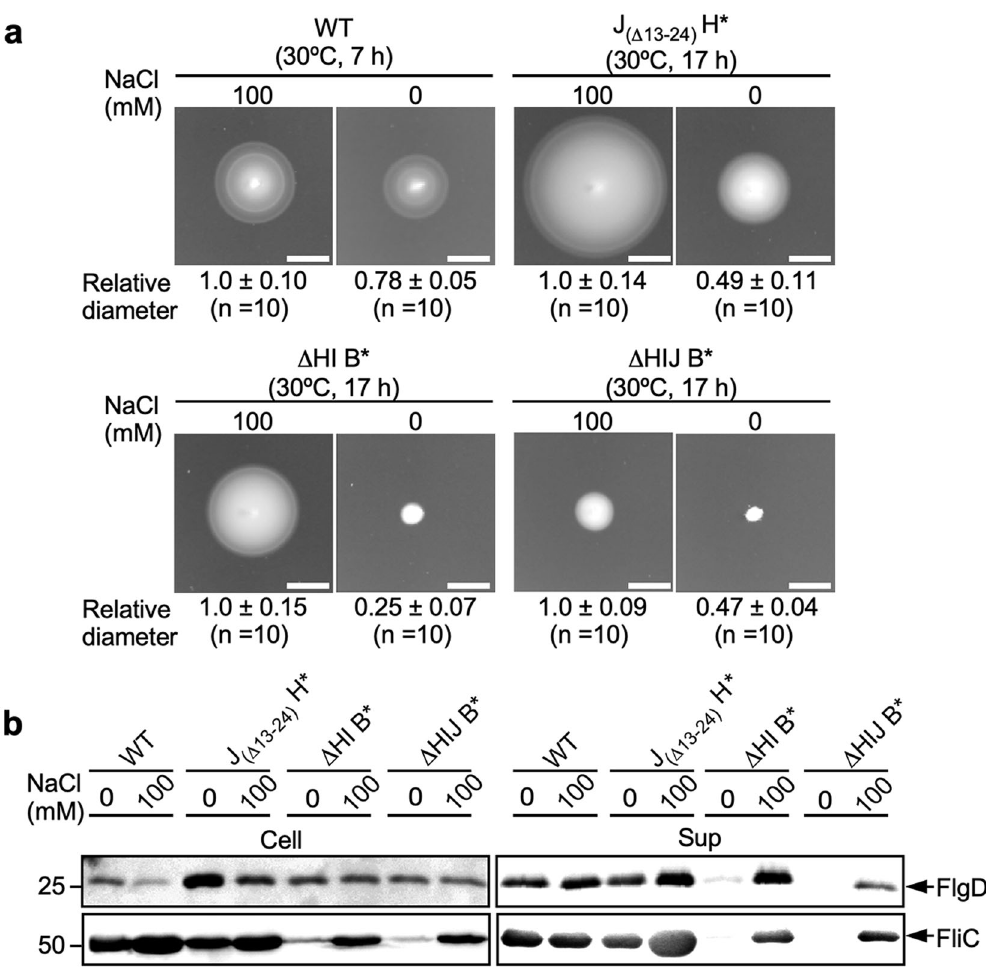
Fig. 1 Effect of Na + ions on fl agellar protein export. a Motility of SJW1103 (wild-type, indicated as WT), MM104H-3 [ fl iJ( Δ 13 – 24 ) fl iH( Δ 96 – 97 ) , indicated as J ( Δ 13 – 24) H * ], MMHI0117 [ Δ fl iH- fl iI fl hB(P28T) , indicated as Δ HI B * ] and MMHIJ0117 [ Δ fl iH- fl iI- fl iJ fl hB(P28T) , indicated as Δ HIJ B * ] in 0.35% soft agar plates in the absence and presence of 100 mM NaCl. The diameter of the motility ring of 10 colonies of each strain was measured in the presence and absence of 100 mM NaCl. The average diameter of the motility ring of each strain grown in the presence of 100 mM NaCl was set to 1.0, and then relative diameter of the motility ring of cells grown in the absence of NaCl was calculated (mean ± SD, n = 10). Scar bar, 1.0 cm. b Effect of Na + on fl agellar protein export at external pH 7.5. Immunoblotting, using polyclonal anti-FlgD or anti-FliC antibody, of whole-cell proteins (Cell) and culture supernatant fractions (Sup) prepared from the above strains grown exponentially at 30 °C in T-broth (pH 7.5) with or without 100 mM NaCl. The regions of interest were cropped from original immunoblots shown in Supplementary Fig.